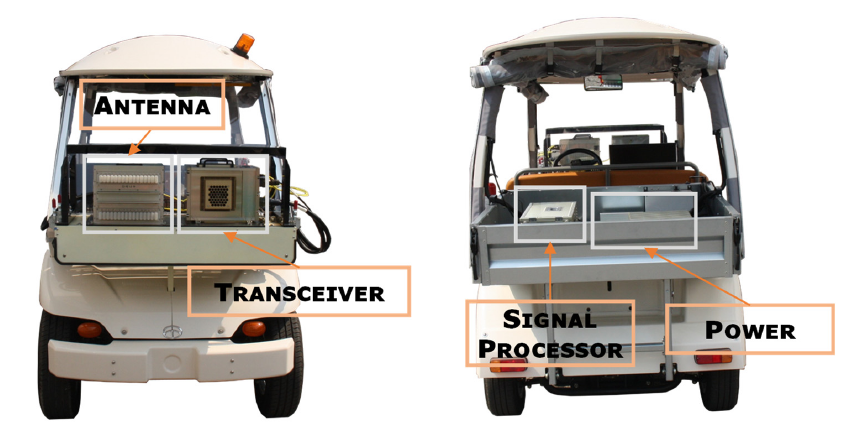
Figure 16. Test vehicle (Front and Back view).